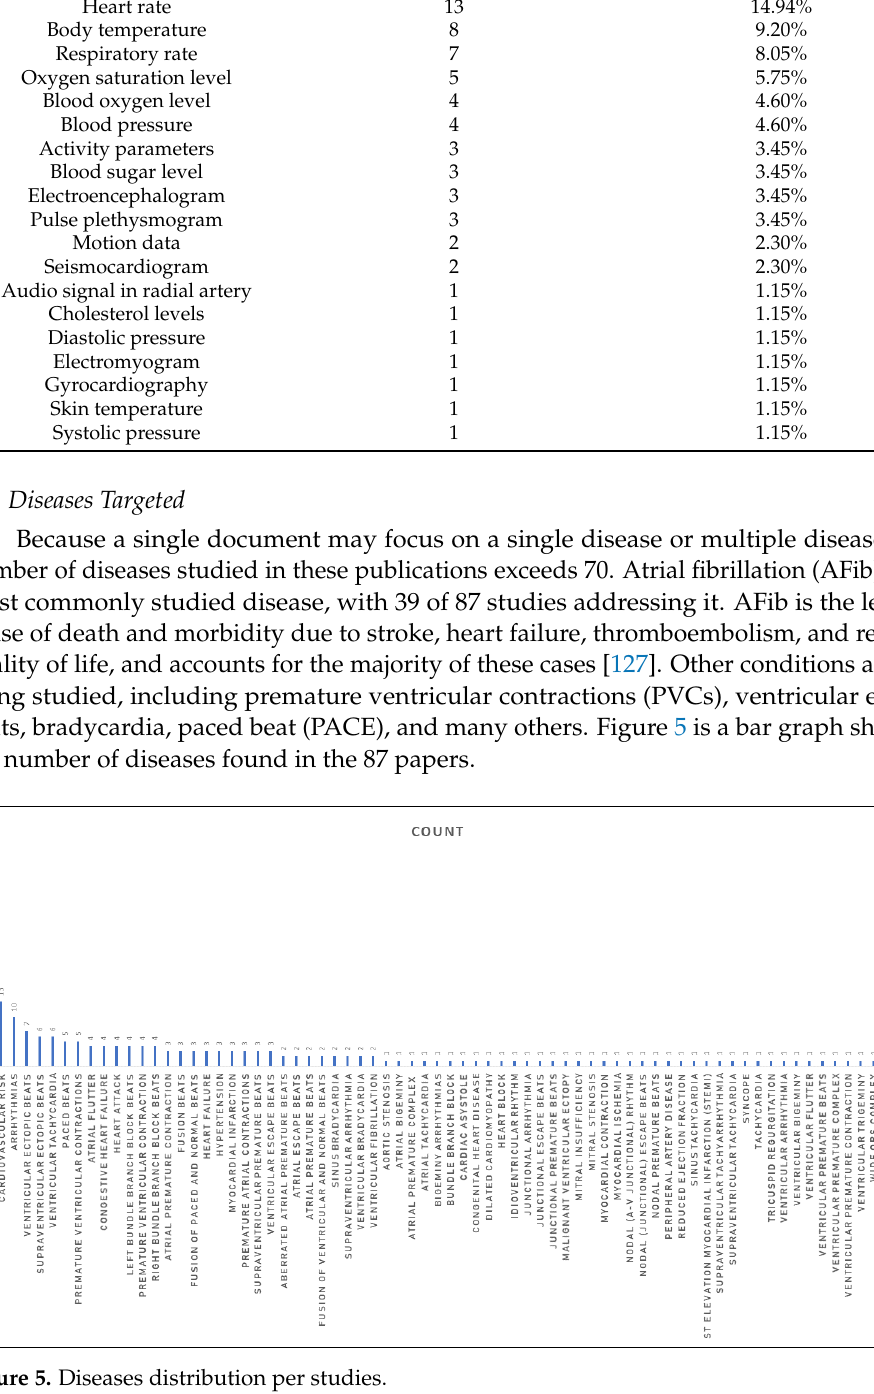
Figure 5. Diseases distribution per